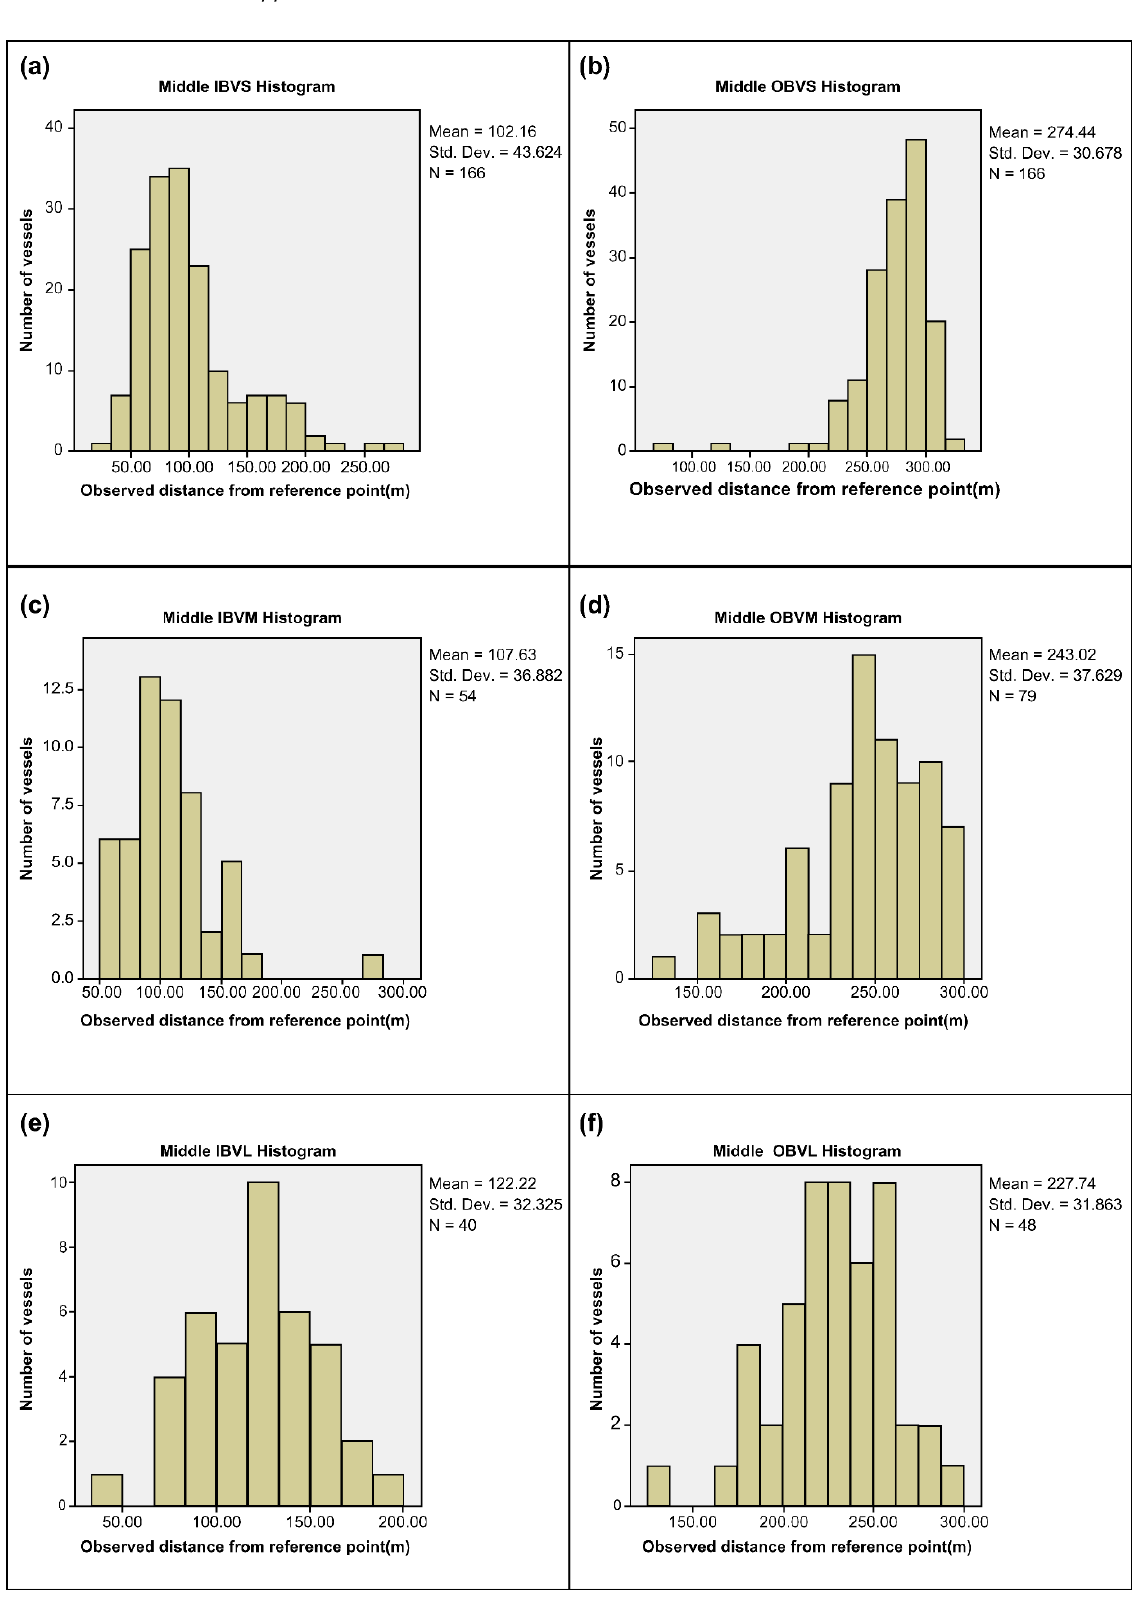
Figure A5. Histogram of the middle part: ( a ) small IBVs, ( b ) small OBVs, ( c ) mid-sized IBVs, ( d ) mid-sized OBVs, ( e ) large IBVs, and ( f ) large OBVs.